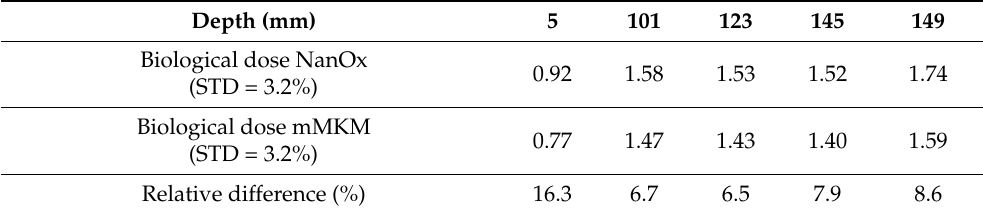
Table 4. Comparison of biological doses obtained with NanOx and MMKM models at 5, 101, 123, 145 and 149 mm